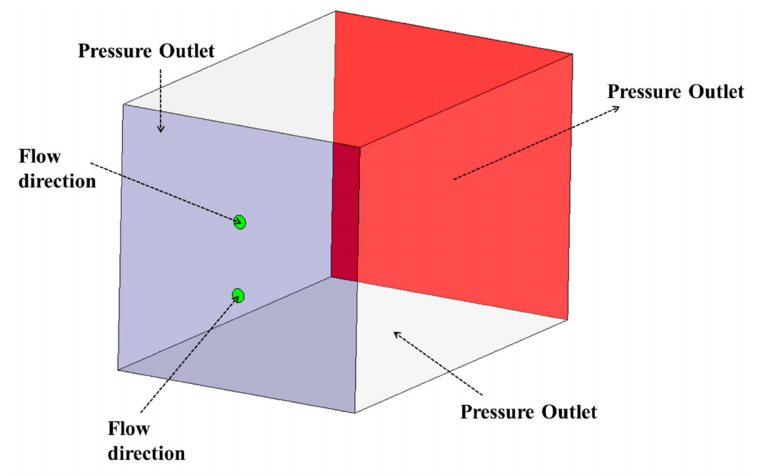
Figure 4. Schematic of boundary conditions used in the